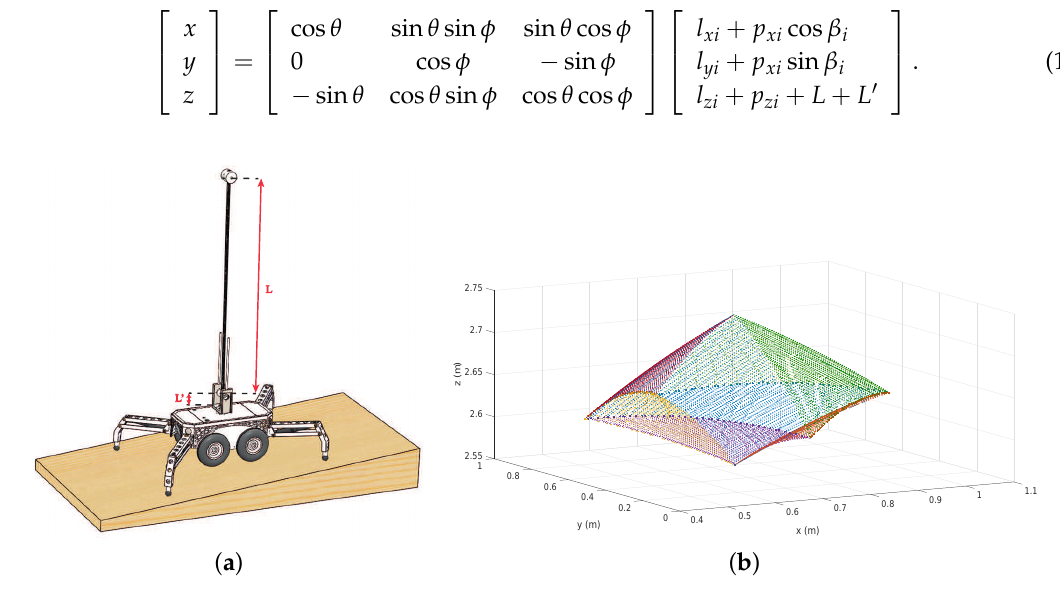
Figure 12. ( a ) the whole system; ( b ) the workspace of the